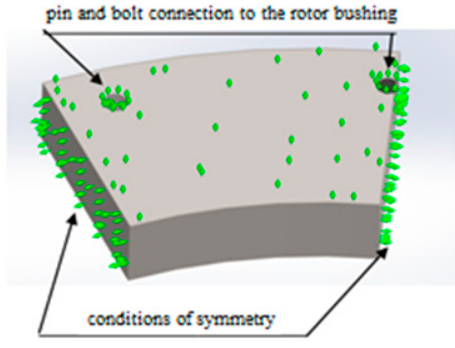
Figure 11. Conditions of the disc fastening.